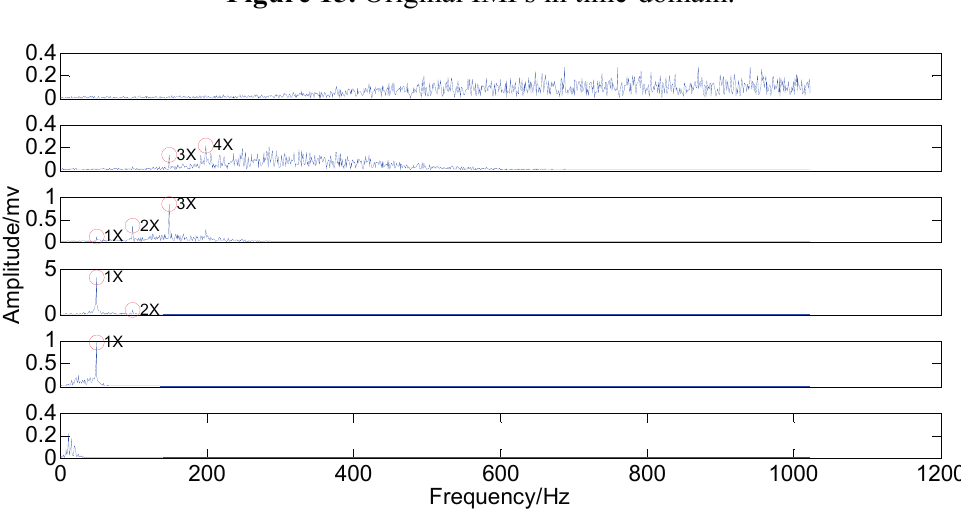
Figure 15. Original IMFs in time-domain.